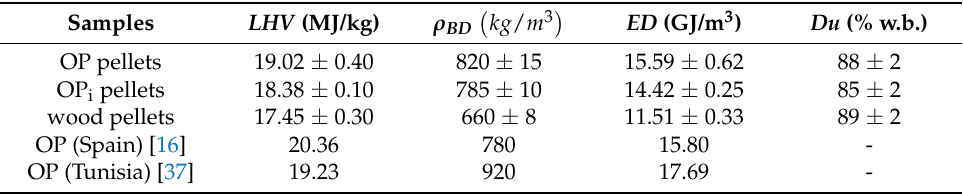
Table 5. Energy contents in the pellets